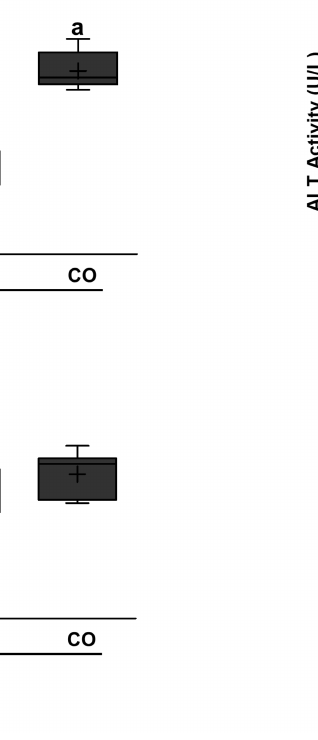
Figure 7. Partial replacement of dietary fat with PO or CO and LPS challenge on hepatic function parameters in serum. Mice were fed either an ND or an ND partially replaced with PO or CO for 12 weeks and then treated with LPS (1 mg/kg) for 24 h ( n = 8 per group). ( A ) Aspartate aminotransferase (AST) activity; ( B ) alanine aminotransferase (ALT) activity; ( C ) alkaline phosphatase (ALP) activity. Values are presented as box and whisker plots representing 8 mice per group. Data were analyzed using one-way ANOVA followed by Tukey’s post hoc test. Labeled means without a common letter differ ( p < 0.05).